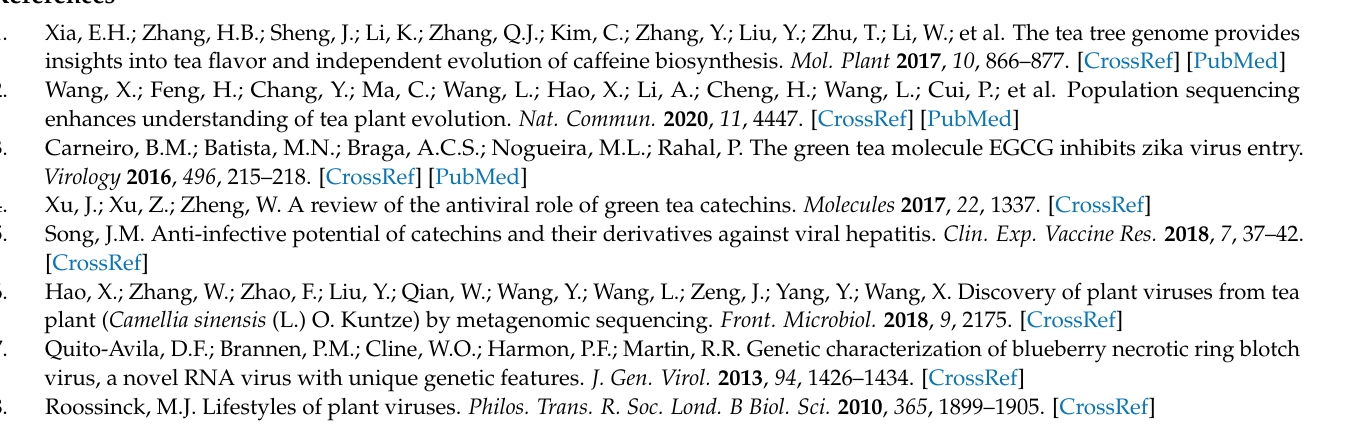
Figure S3: Amplification curves of TPNRBV plasmid by RT-qPCR; Table S1: Primers used for the construction of recombinant plasmids containing cDNA clones of TPNRBV; Table S2: RT-qPCR primer sequences; Table S3: Raw C t values of all